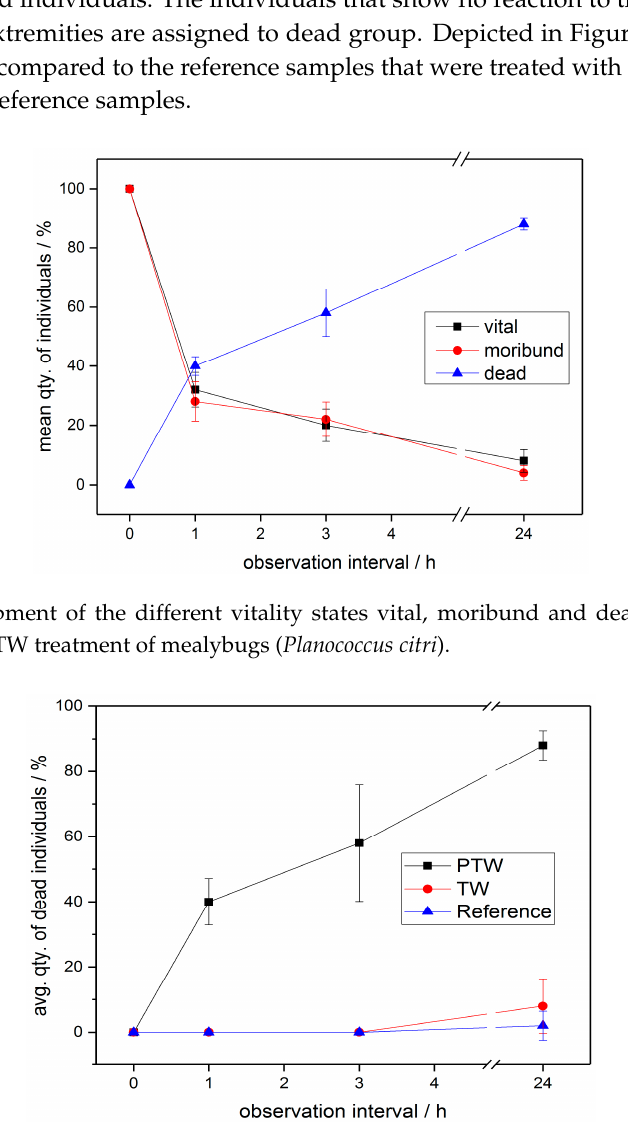
Figure 6. Comparison of mortification rates obtained using PTW and untreated TW vs. untreated reference samples. 3 replicates consisting of 10 individuals per treatment were used. The significance of differences between the treatment methods and the dry control were tested globally by one ‐ way ‐ ANOVA at α = 0.001 with correction for multiple testing, according to Bonferroni. The significant differences between PTW and TW are given with p = 6.82 × 10 − 9 , ( σ = 1). No significant differences between TW and dry reference were found.